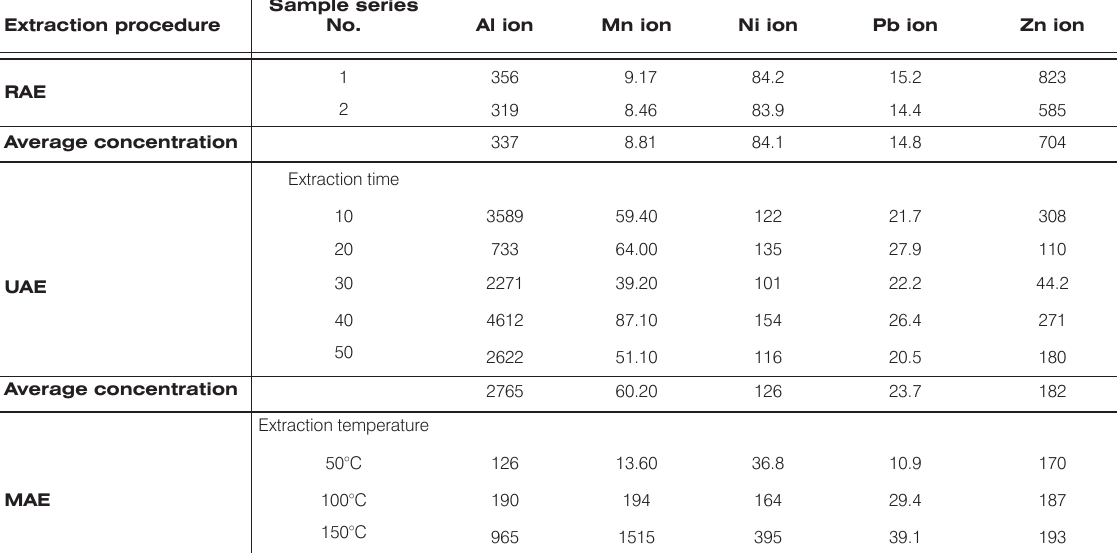
Table 8. The results of determinations of total ion content of Al, Mn, Ni, Pb and Zn obtained by ICP-AES, after three extraction techniques (μg/100 g soil). Sample series Extraction procedure